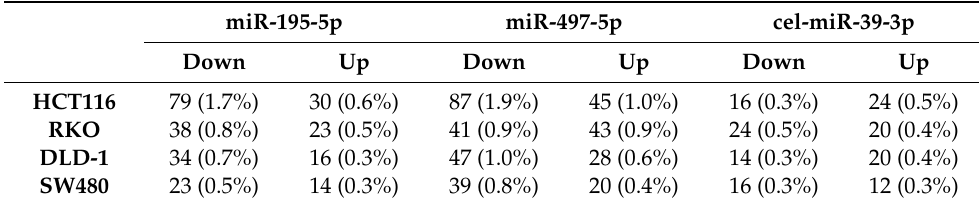
Table 1. Numbers of di ff erentially up- or downregulated proteins after transfection of each miRNA mimic. For miR-195-5p and miR-497-5p numbers represent significant up- or downregulated proteins comparedtothecellstransfectedwithcel-miR-39-3p( p < 0.05, foldchange > 3or < − 3). Forcel-miR-39-3p numbers represent significant up- or downregulated proteins compared to the non-transfected wild-type